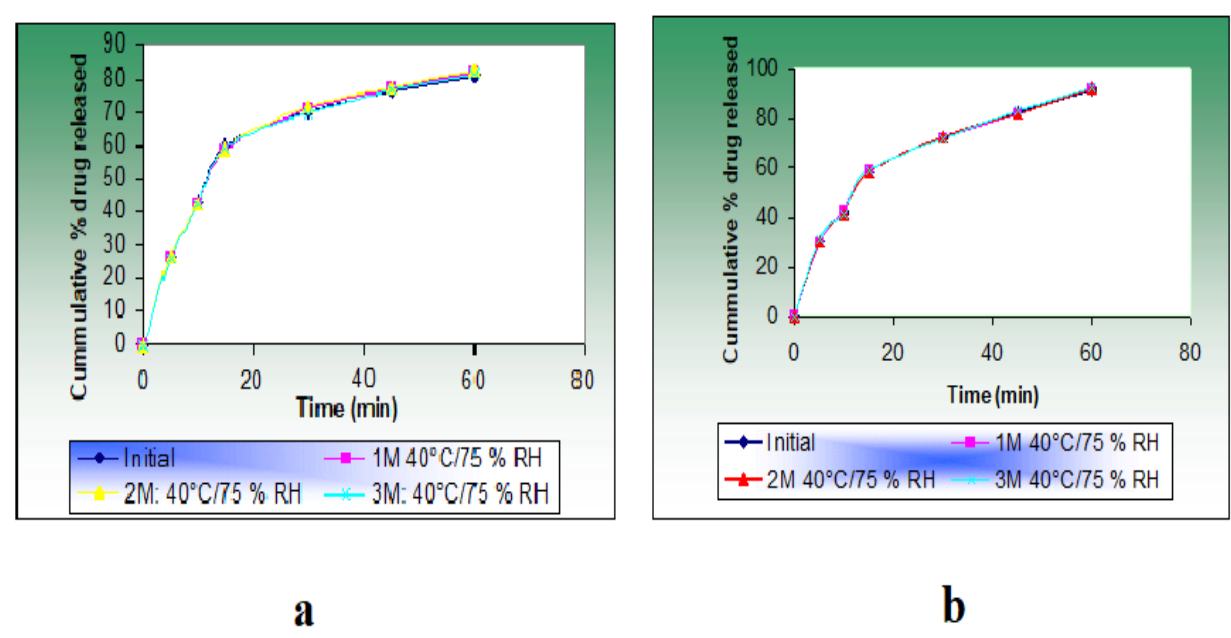
Figure 27. Comparison of in vitro dissolution characteristics of Meloxicam/Poloxamer solid dispersions fabricated using ( a ) the melting process and ( b ) the microwave method. Reproduced with permission from [327].